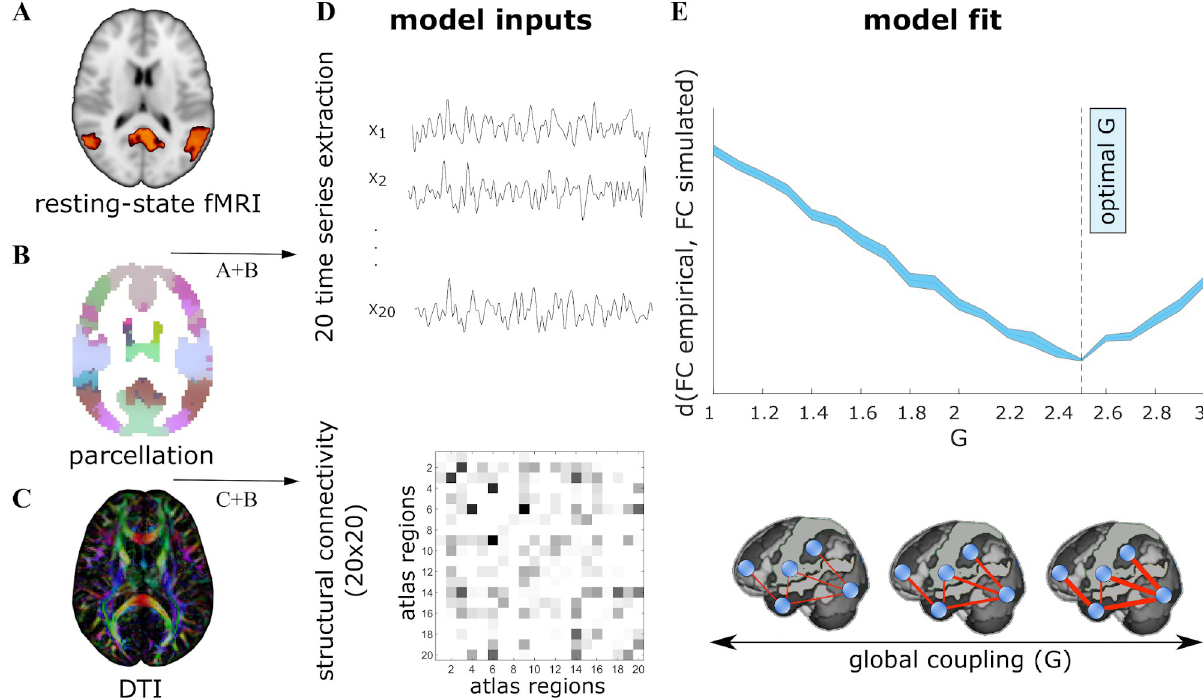
Fig 1. Whole-brain dynamic mean field model. The DMF model has several inputs. A : BOLD signals from fMRI data, B : a parcellation, in our case comprising 20 atlas regions, and C : the individual connectome obtained from DTI. D : Applying the parcellation to the fMRI and DTI datasets, we obtained 20 time-series signals and a 20 × 20 matrix representing the connectome. E : BOLD-like signals are simulated using the connectome and different values of the coupling parameter G . For each G , we compare the simulated and empirical data using the Kolmogorov-Smirnov distance ( d ) over the distribution of values of the FC matrices. Finally, the selected optimal G is the value that minimizes this distance.